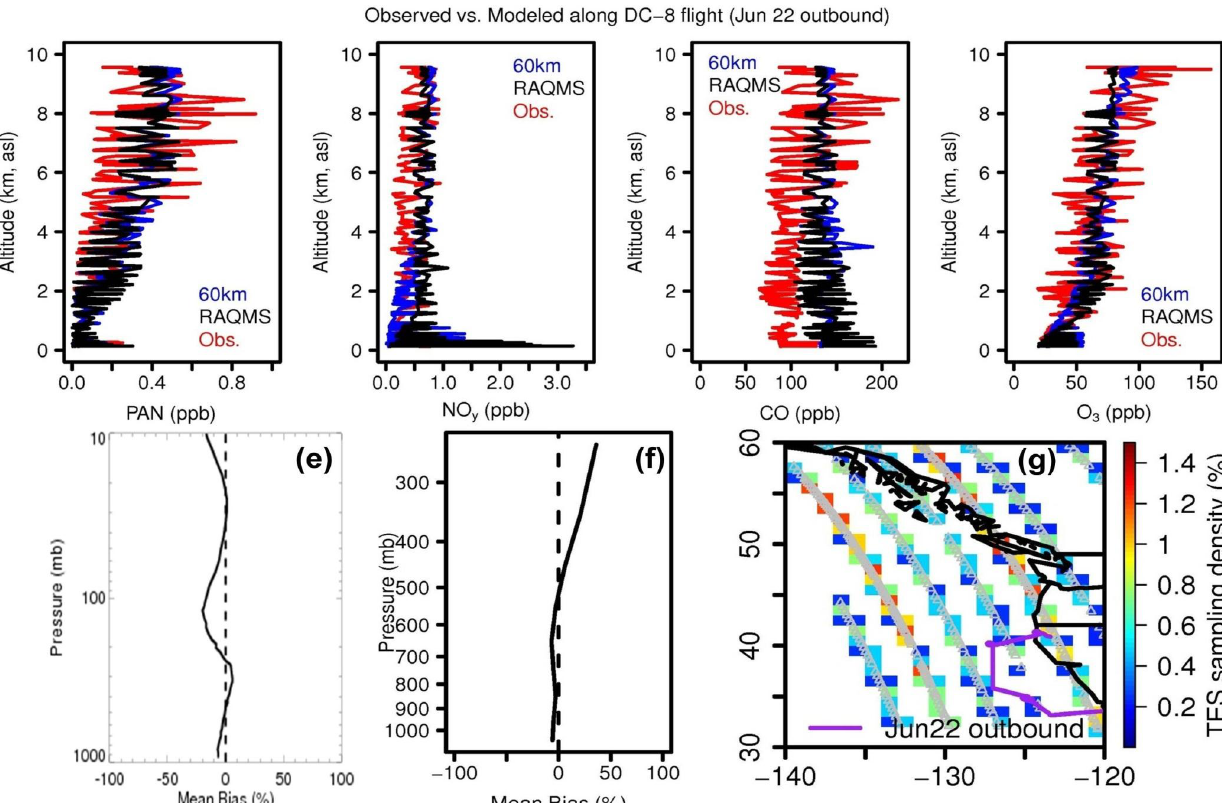
Fig. 1. Observed and modeled (RAQMS and STEM 60km) vertical profiles along the outbound part of the 22 June DC-8 flight, for (a) PAN; (b) NO y ; (c) CO; and (d) O 3 . Comparison between TES and (e) RAQMS and (f) STEM 60km modeled O 3 over the eastern Pacific. TES observational operator was applied. (g) TES special observation sampling density in the compared domain for STEM. Sampling den- sity=number of samples in each 1 ◦ × 1 ◦ /total number of samples. The outbound part of the 22 June DC-8 flight path is shown as purple